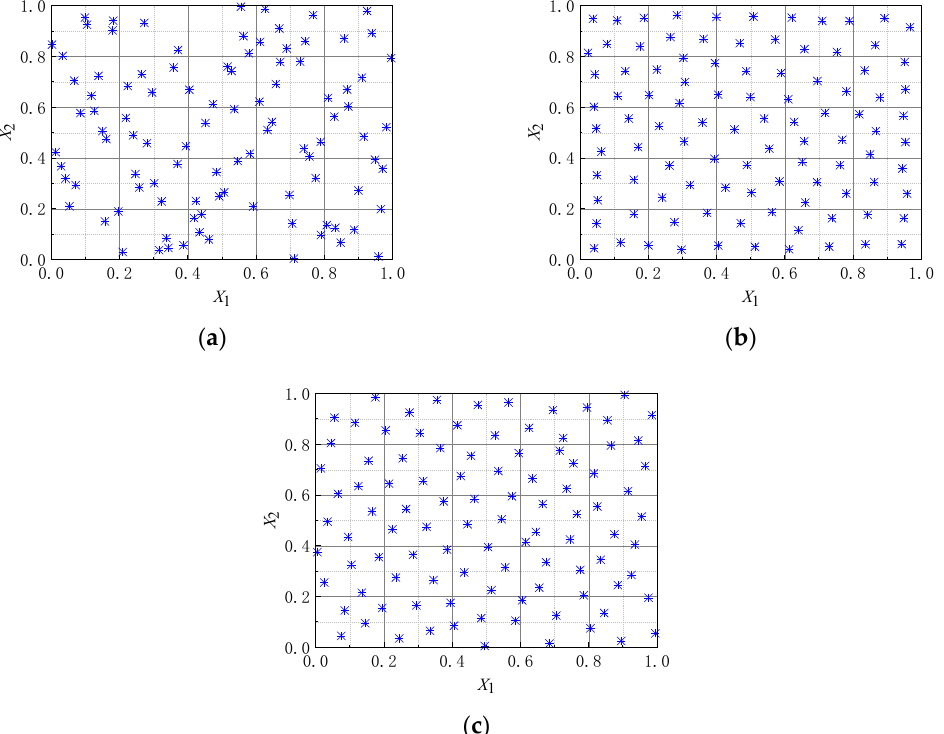
Figure 2. Comparison of the effect of sampling 100 sample points in two dimensions by different sampling methods. (The blue asterisk in figures are the sample points.) ( a ) Latin hypercube sampling; ( b ) CVT sampling; ( c ) LCVT sampling.